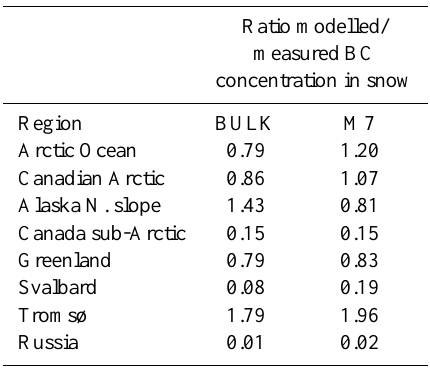
Fig. 6. BC concentration [ng g − 1 ] in snow and ice in April in the Northern Hemisphere (in the top 5cm of snow) (a) using BULK and (b) difference between M7 and BULK.